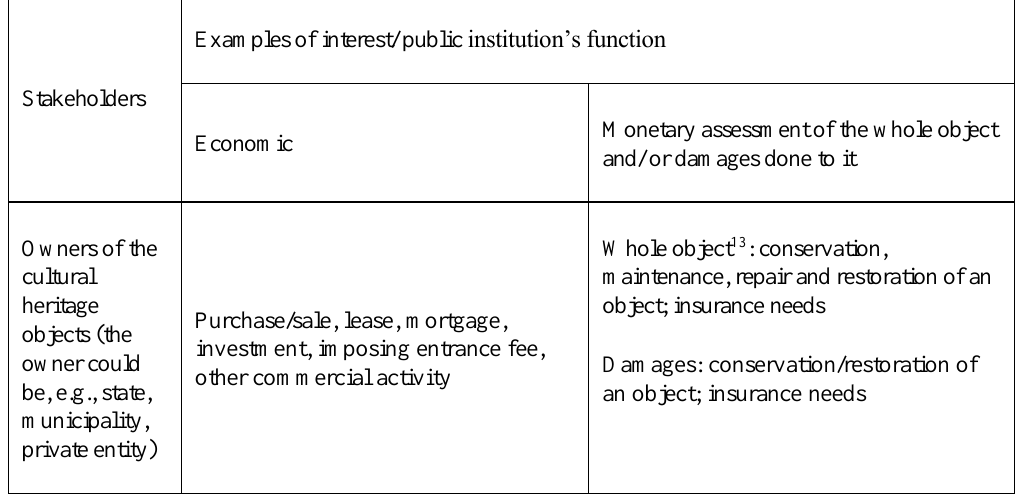
Table 1. Examples of Stakeholders and their Economic Interests in Immovable Heritage Objects (Cultural